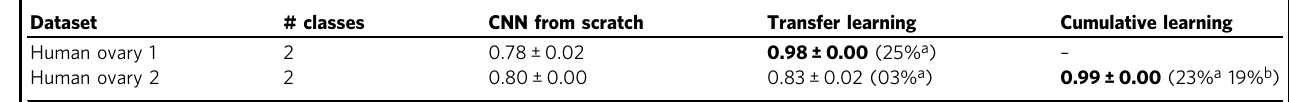
The best result for each task (accuracy±standard variation over 10 independent iterations) is indicated in boldface. a The improvement is expressed as a percentage relative to learning from scratch. b The improvement is expressed as a percentage relative to transfer learning.